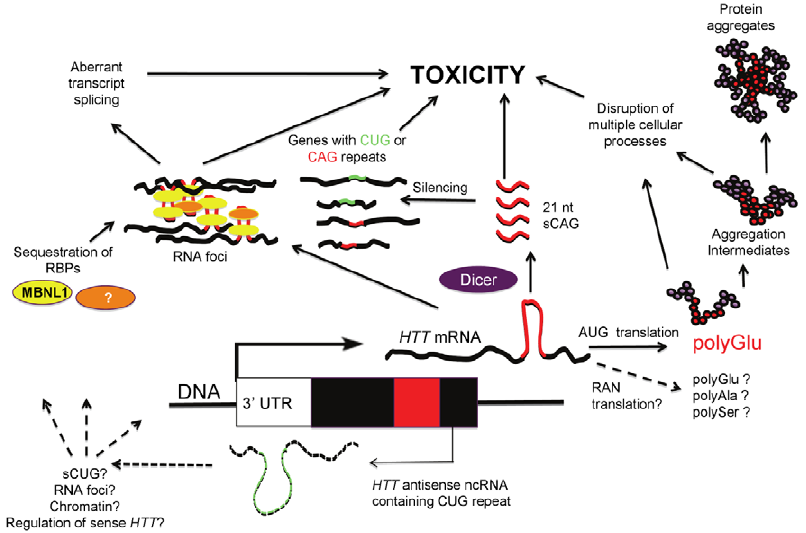
Figure 1. RNA contribution to HD pathogenesis. An HTT transcript with an expanded CAG repeat is expressed and translated into the huntingtin protein containing an expanded polyglutamine tract. The expanded polyglutamine tract leads to cell toxicity through multiple pathways. It is possible that RAN (Repeat Associated Non-ATG Translation) could generate polypeptides containing polyglutamine, polyalanine, or polyserine tracts that contribute to pathogenesis. In parallel, the expanded repeat in the transcript forms a hairpin that is cleaved by Dicer into 21-nt fragments that lead to toxicity, at least in part based on silencing of other genes that contain CUG and CAG repeats. In addition, HTT transcripts with expanded CAG repeats may accumulate into RNA foci, sequestering RNA binding proteins like MBNL1, leading to toxicity via mechanisms that most likely include aberrant gene splicing. A transcript antisense to the HTT gene may also participate in disease pathogenesis through dysregulation of the HTT sense transcript, formation of sCUG, and/or formation of RNA foci with protein